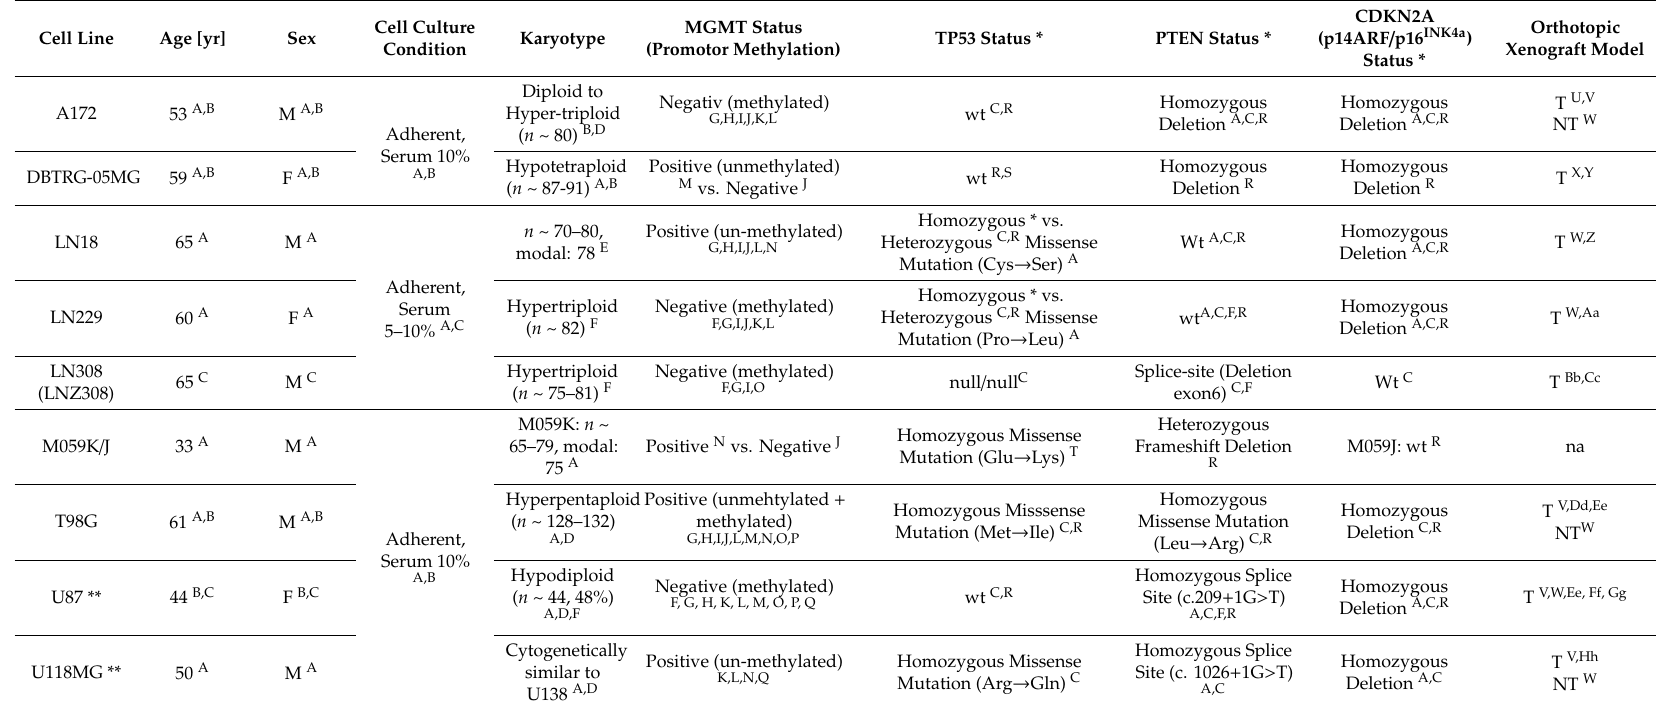
Table 3. Characteristics of a panel of 12 commercially available GB cell